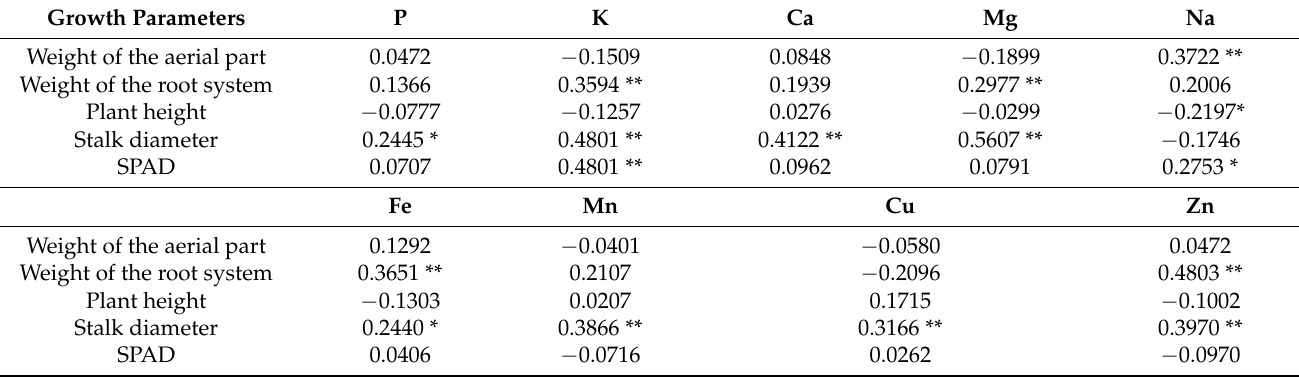
Table 7. Linear correlation coefficients (n = 81) between the amount of macro- and micronutrients accumulated in the fruit yield per m 2 , and growth parameters of plants and the value of SPAD